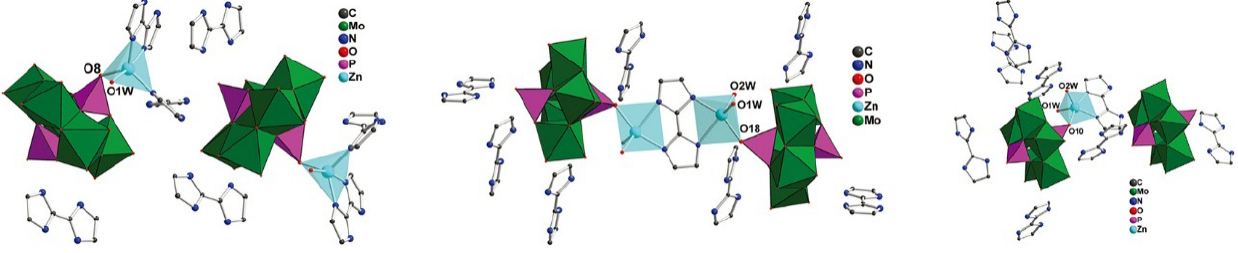
Figure 4. Combined polyhedral and ball-and-stick representation for the three hybrid compounds based on [P 2 Mo 5 O 23 ] 6 − and Zn-H 2 biim coordination complexes. Reproduced with permission from RSC, 2014